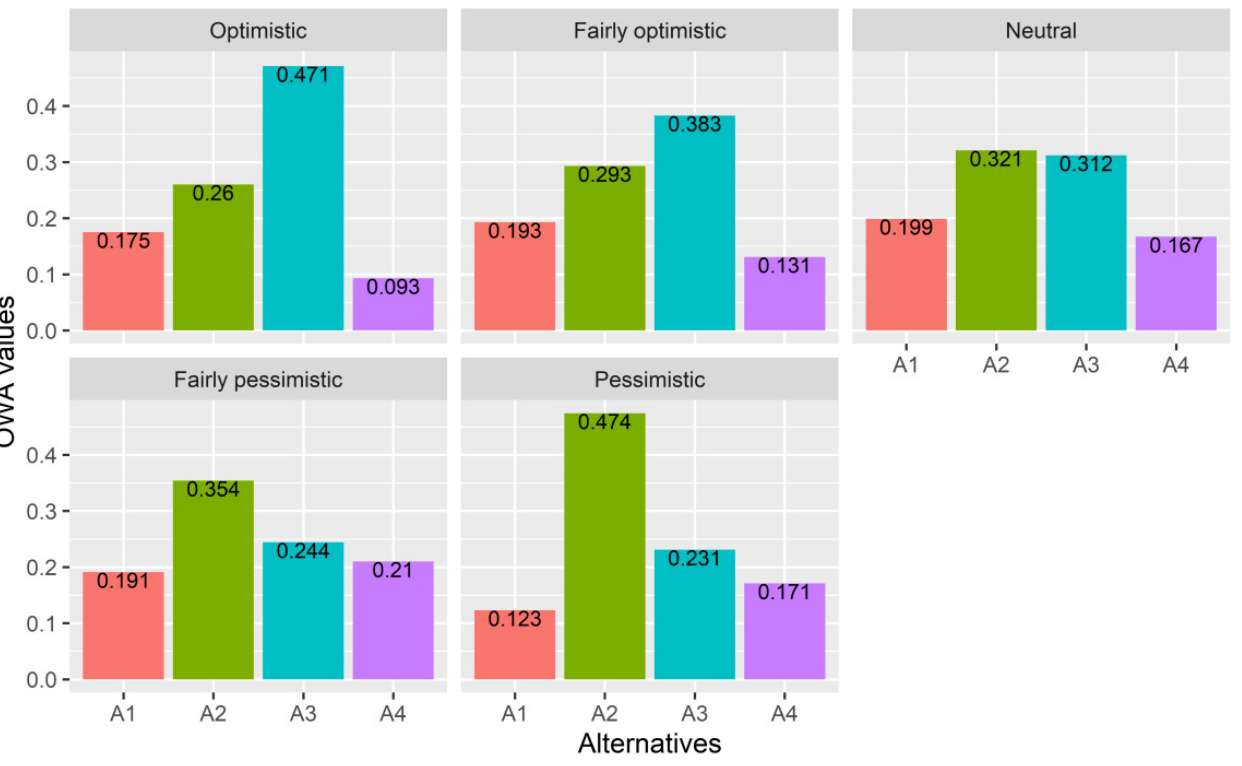
Figure 4. OWA values (five scenarios), A1 refers to “business as usual”, A2 refers to “eco-tourism”, A3 refers to “protection of natural ecosystems”, and A4 refers to sustainable agriculture.